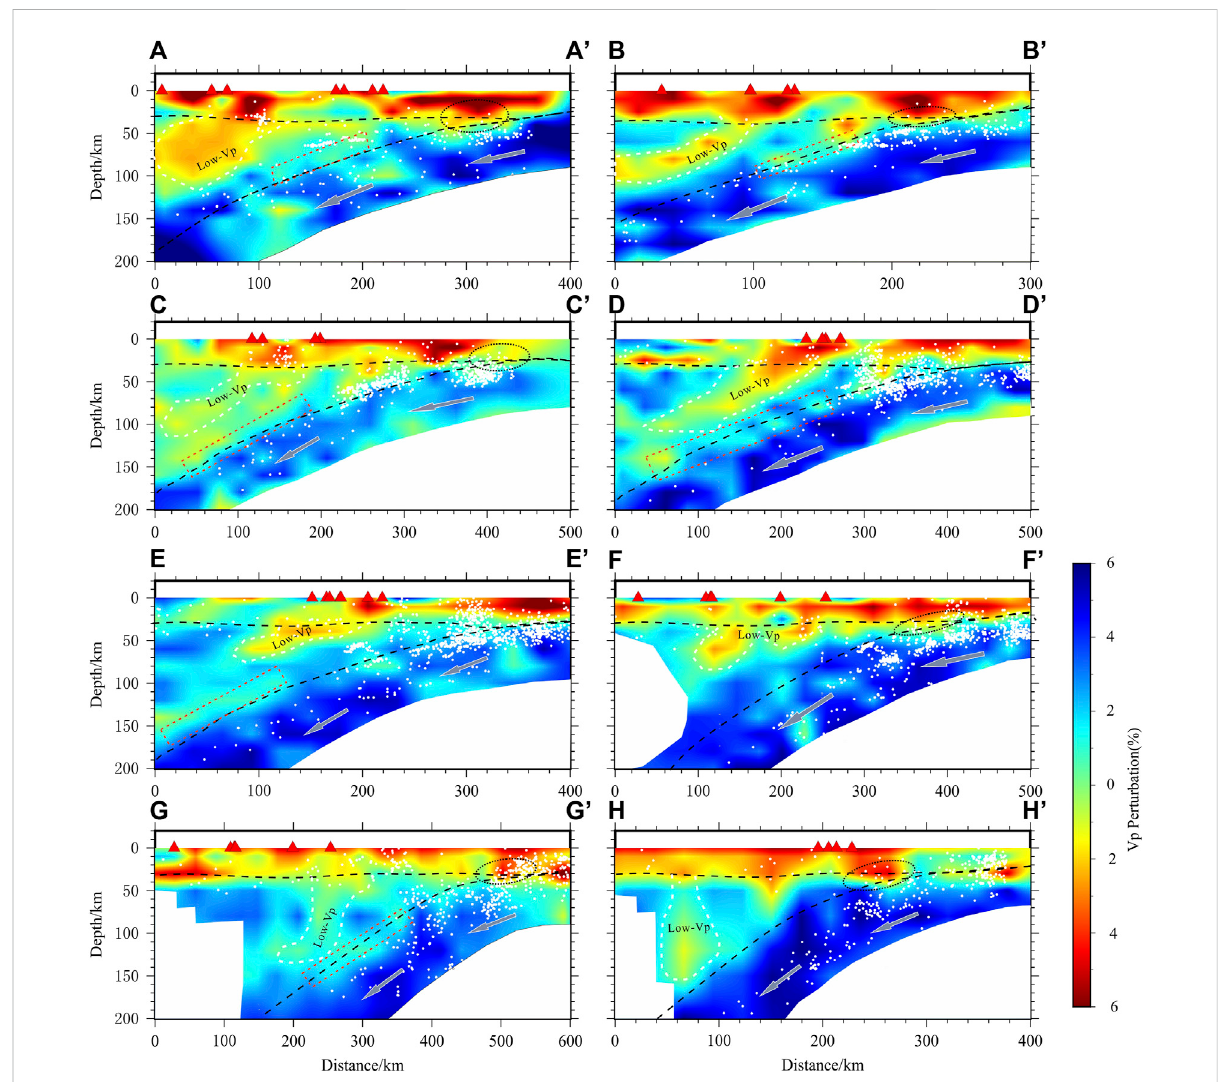
FIGURE 10 Vertical cross-sections of P-wave velocity ( Vp ) tomography along the 8 pro fi les shown on the Figure 2A. The red and blue colors denote low and high Vp perturbations (in %). The scales of Vp perturbation are exhibited at the right. Two black dash lines show the discontinuities of the Moho and the upper interface of the subducting Paci fi c plate along each section, respectively. The red triangles denote the active arc volcanoes. The gray arrow mark indicates the direction of subduction of the Paci fi c plate. The white dashed area represents the low-velocity anomaly in the mantle wedge. The white dots represent the relocated earthquakes within ~35 km near the pro fi